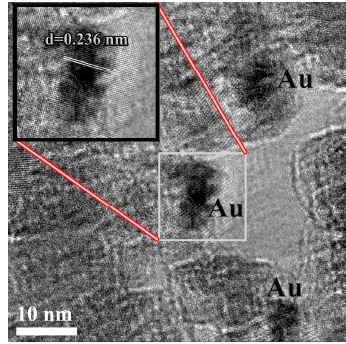
Figure 2. HRTEM image of 2.43 × 10 − 3 % Au–S–CH 2 –CH 2 –OH/TiO 2 (0.5 g/L) sample representing Au nanoparticles distributed over the TiO 2 matrix. Inset has enlarged section of selected Au nanoparticles with the marked crystalline planes.